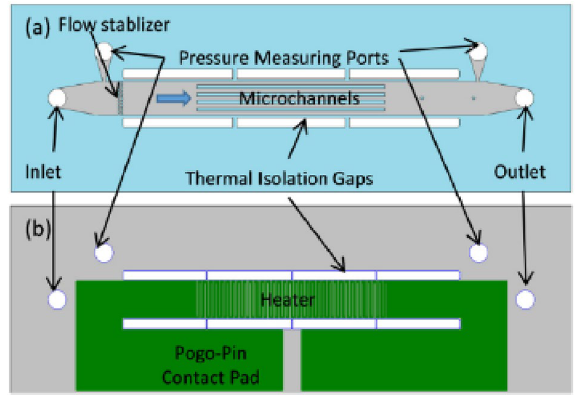
Figure 3. Micro devices configurations ( a ) front-side and ( b ) back-side of the microchannel device 27